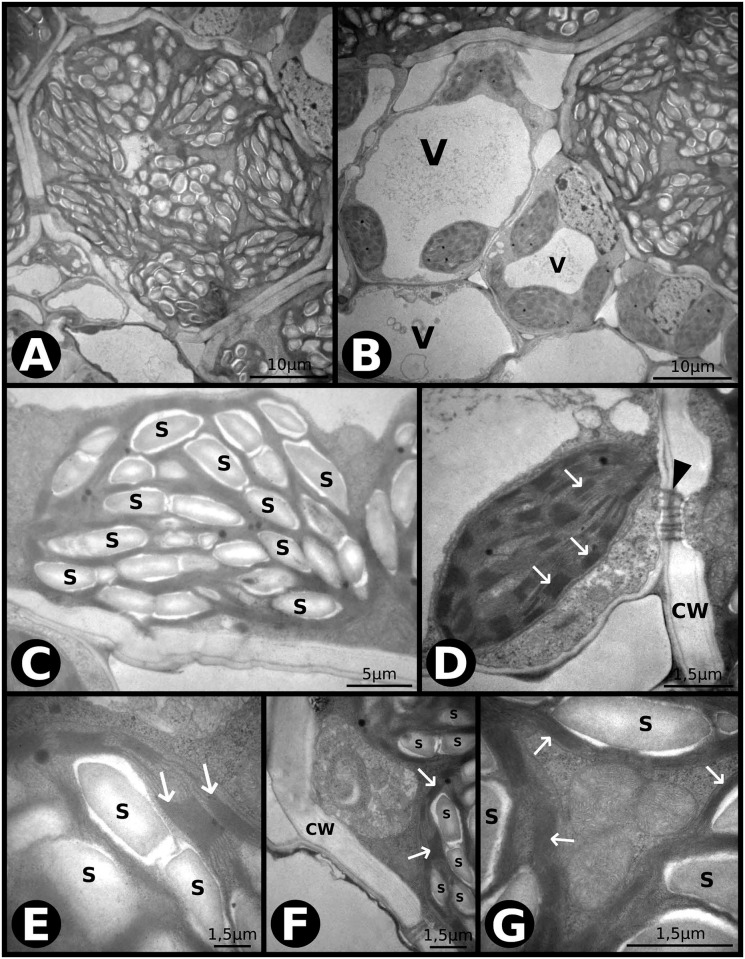
Transmission electron microscopy (TEM) photomicrographs of leaves of P. maximum under elevated [CO2] and ambient temperature (eCaT).(A) Overview of a bundle sheath cell (BSC). (B) Overview of mesophyll cells (MC). V–vacuole. (C) Chloroplast of a BSC with large starch grains. S–starch. (D) Chloroplast of a MC with conserved thylakoid membranes (indicated by arrows) and communication thought plasmodesmata with a BSC (indicated by an arrowhead). CW–cell wall. (E) A chloroplast of a BSC showing details of thylakoid membranes (indicated by arrow). S–starch. (F) Regular cell wall of a BSC and chloroplasts with starch grains and conserved thylakoid membranes (indicated by arrows). CW–cell wall, S–starch. (G) Group of mitochondria associated with chloroplasts in BSC with conserved thylakoid membranes (indicate by arrows). S–starch, M–mitochondria.